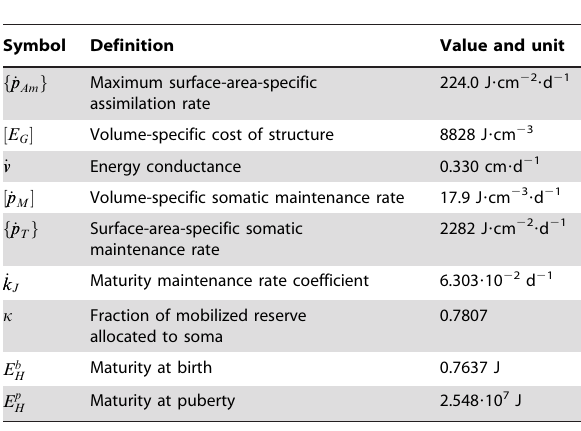
Table 5. List of symbols II: basic DEB